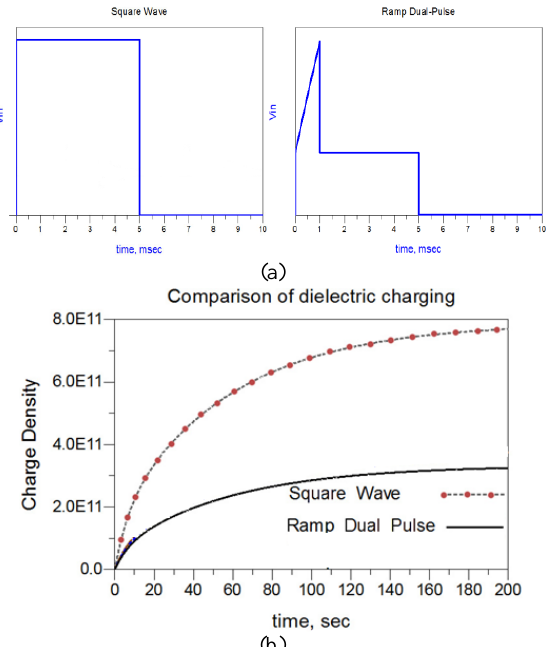
Figure 2. Comparison of charge effect of driver. (a) Pulse and RDP. (b) Comparing the amount of charge due to the effect of pulse.